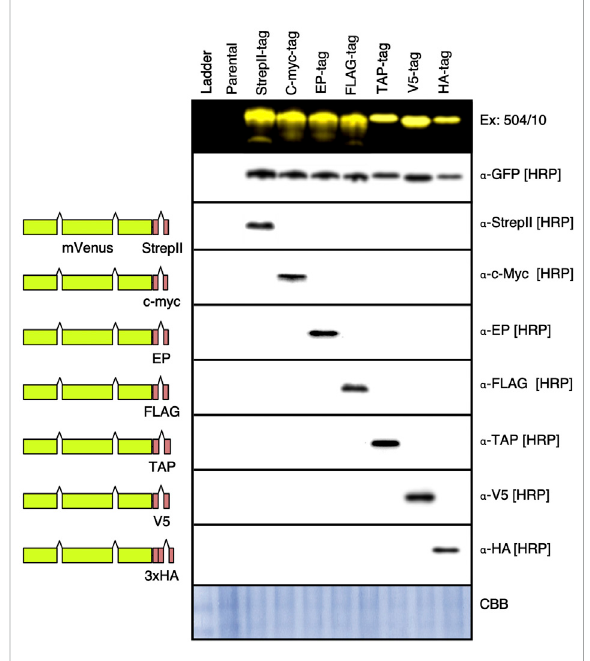
FIGURE 4 Western blot of different epitope tags expressed in